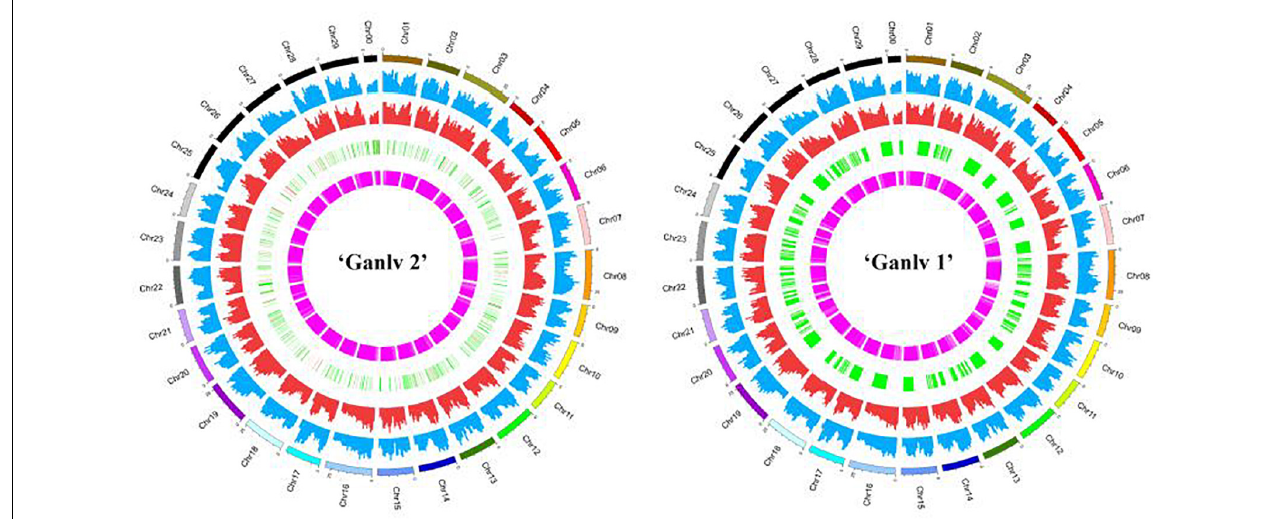
FIGURE 9 | Circos of ‘Ganlv 2’ and ‘Ganlv 1’. The outermost circle represents the chromosome and its position. From the outside to the inside are single nucleotide polymorphism (SNP) frequency, Indel frequency, position and length of copy number variation (CNV), and position and length of structural variation (SV). In the circle where CNV is located, the red region represents chromosome copy number amplification, and the green region represents chromosome copy number deletion.